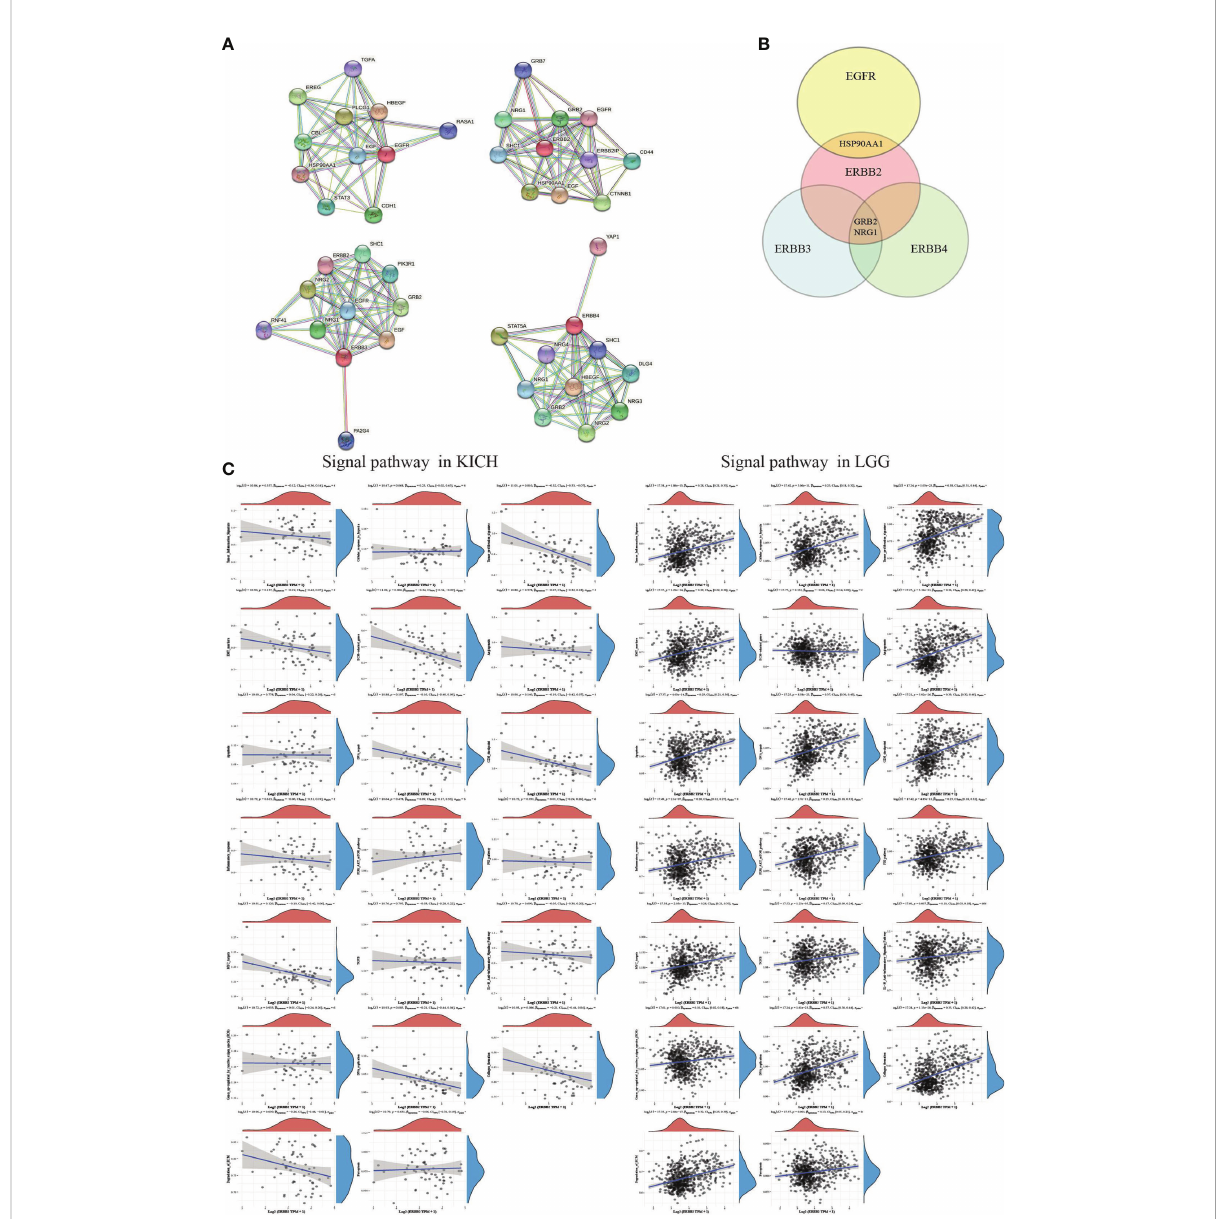
FIGURE 6 The correlations between individual genes and pathway score. (A) The protein-protein interaction network functional enrichment analysis between EGFR family members. (B) A Venn diagram identi fi ed that the ERBB2 receptor recruits adapter proteins like GRB2 and NRG1, which activates complex downstream signaling cascades using the STRING database. (C) A map of KICH and LGG showed the correlation of ERBB2 enrichment and various signaling pathways. The abscissa represents the distribution of the ERBB2 gene expression, and the ordinate represents the distribution of the pathway score. The density curve on the right represents the trend in the distribution of pathway scores. The upper- density curve represents the trend in the distribution of gene expression. The value on the top represents the correlation p-value, correlation coef fi cient, and correlation calculation